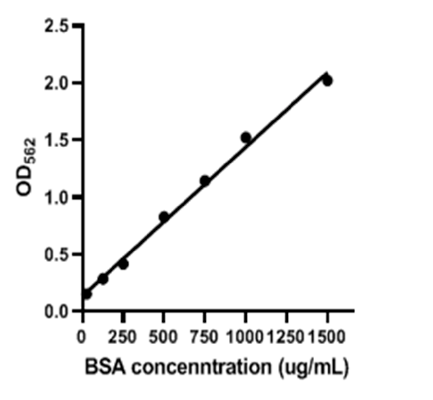
Figure 4. Tricine-SDS-PAGE analysis of the purified gEGF protein. Lane 1: Spectra Multicolor Low Range Protein Ladder (kDa). Lane 2: 20 μ L/well of protein purified from the supernatant of 300 mL LL-pNZ8149-gEGF cultures. The recombinant gEGF is marked with an arrowhead at 7 kDa.